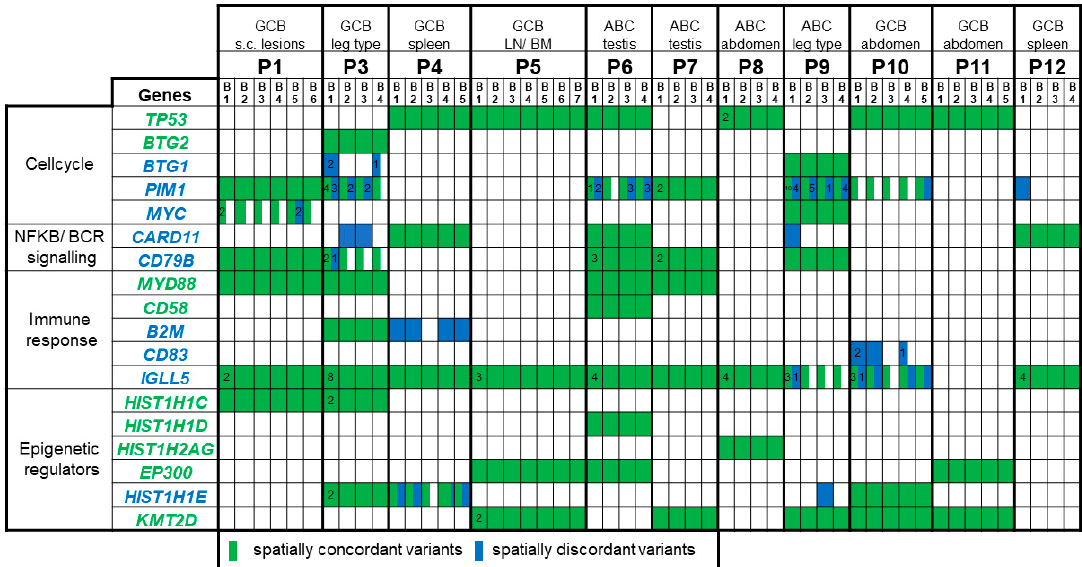
Figure 2. Selected genes with a known relevance for lymphoma biology. Concordant mutations which were found in all biopsies (B) are marked in green and discordant mutations which were found with an allelic frequency of at least 10% in one of the samples of a patient but not detected in at least one other are shown in blue. In some genes, several mutations were found in one patient. If multiple mutations were found, the number of mutations is given within the cell.